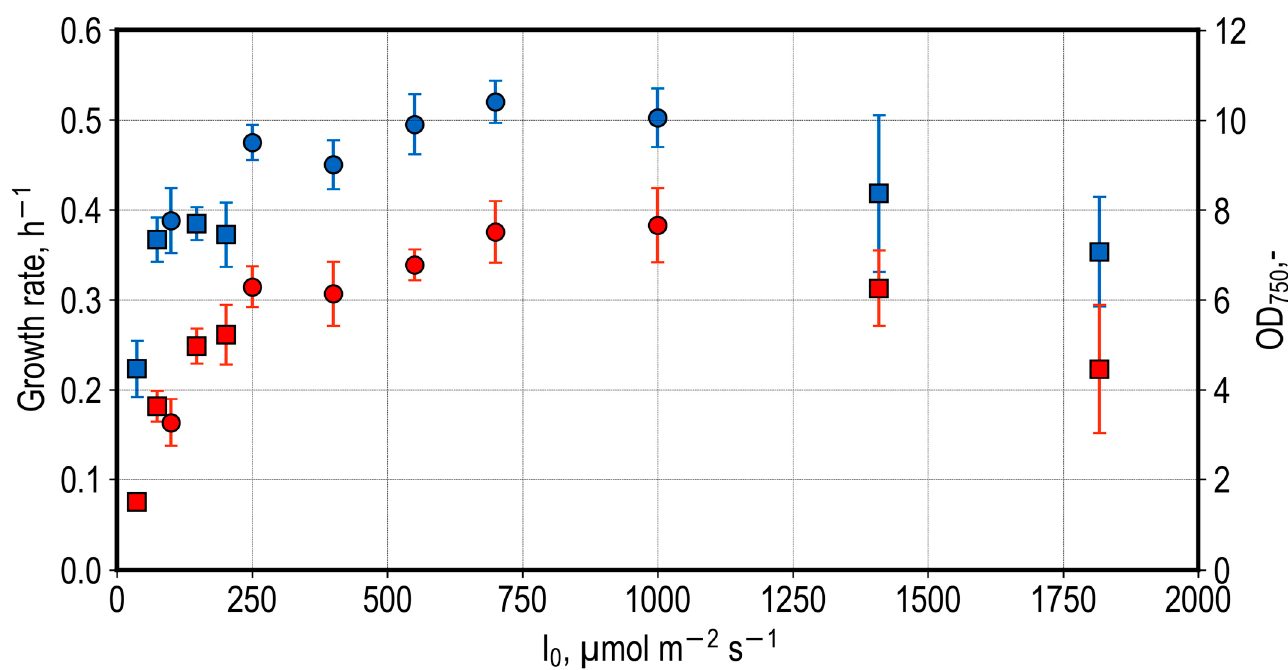
Figure 8. Automated photoautotrophic batch cultivations of M. salina in miniaturized stirred-tank PBRs ( ● fi rst experiment, ■ second experiment). Estimated exponential growth rates of M. salina (blue) and OD 750 after 6 d as a function of the constant incident light intensities I 0 (red). Standard deviations are based on n = 8 parallel stirred-tank bioreactors.